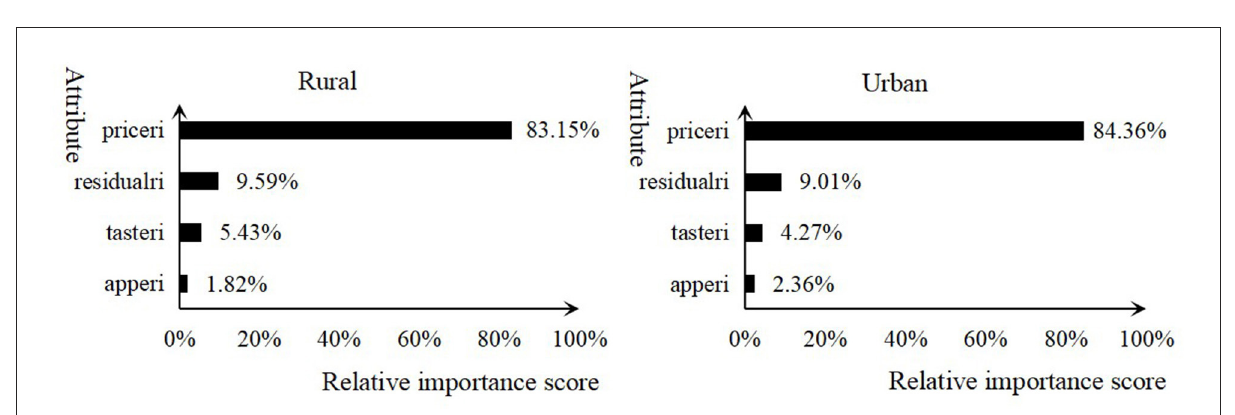
FIGURE2 Rural and urban consumer relative importance score of the